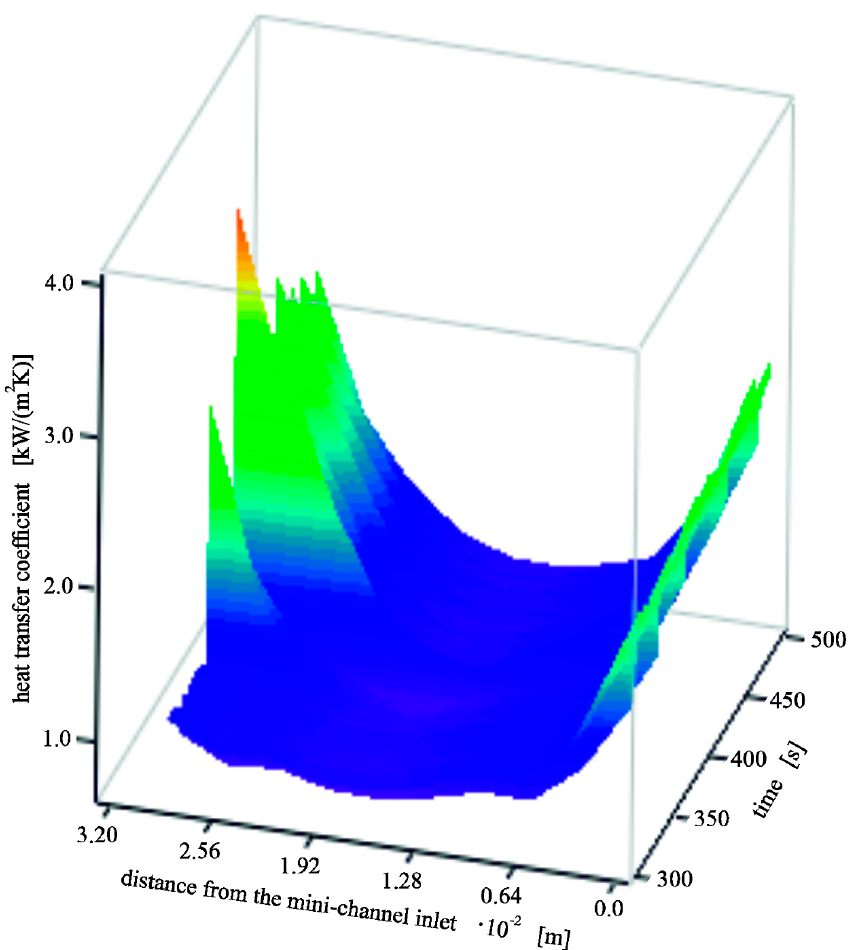
Figure 16. Heat transfer coefficient according to the FEMT computation versus time and distance from the mini-channel inlet; experimental parameters are listed in Table 1. Table 3. Distinctive features of the mathematical methods used in